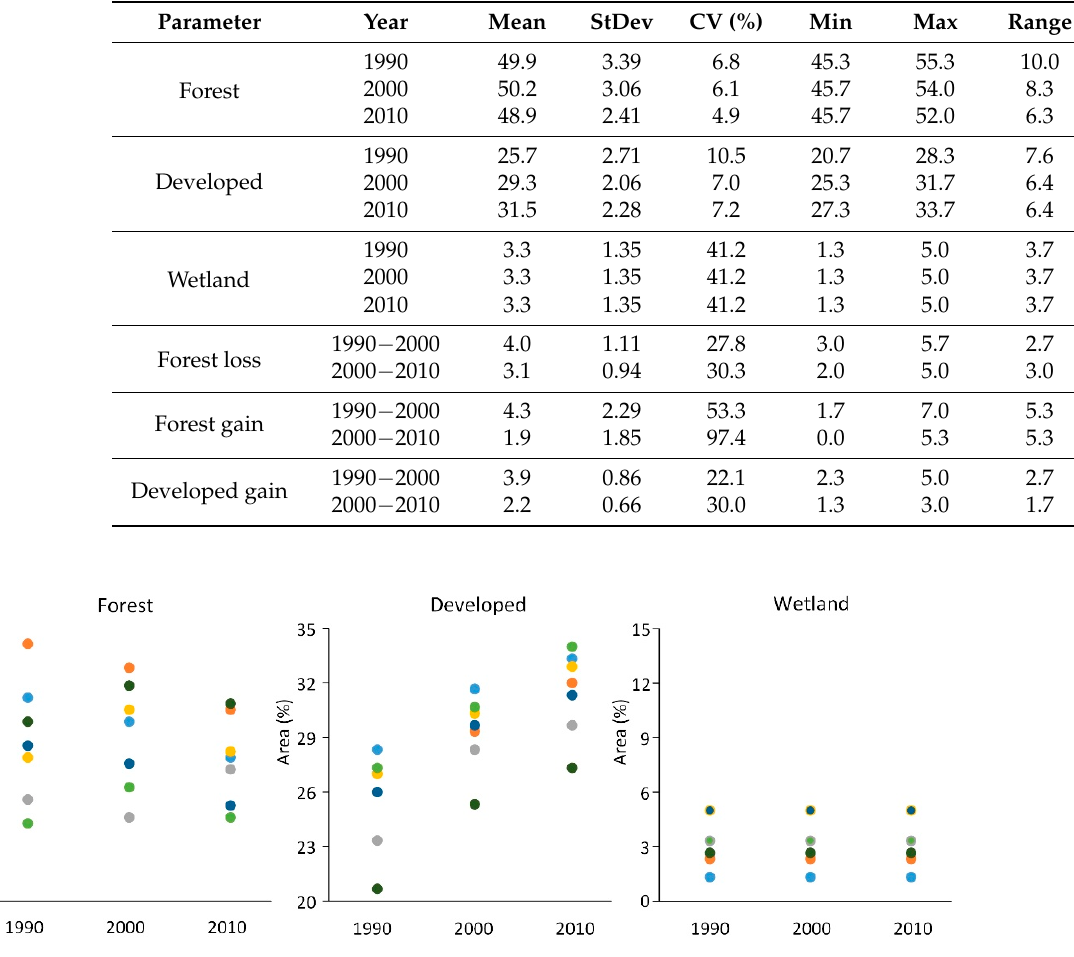
Table 3. Mean and variability of the land cover and land cover change percent area estimates produced from single interpreters. Parameter